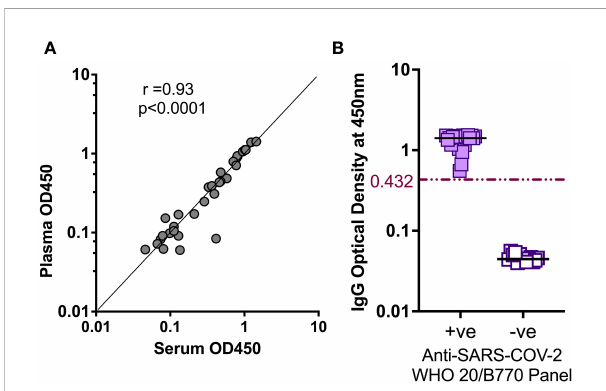
FIGURE 4 Validation of In-House ELISA parallelism and accuracy. (A) shows the parallelism of OD450 values from assays using serum and plasma of the same test subject. (B) shows the accuracy of the in-house ELISA veri fi ed against negative and positive specimens in WHO anti-SARS- CoV-2 veri fi cation standard panels. The ROC-derived cut-off of 0.432 accurately categorised the standard negative and positive specimens.